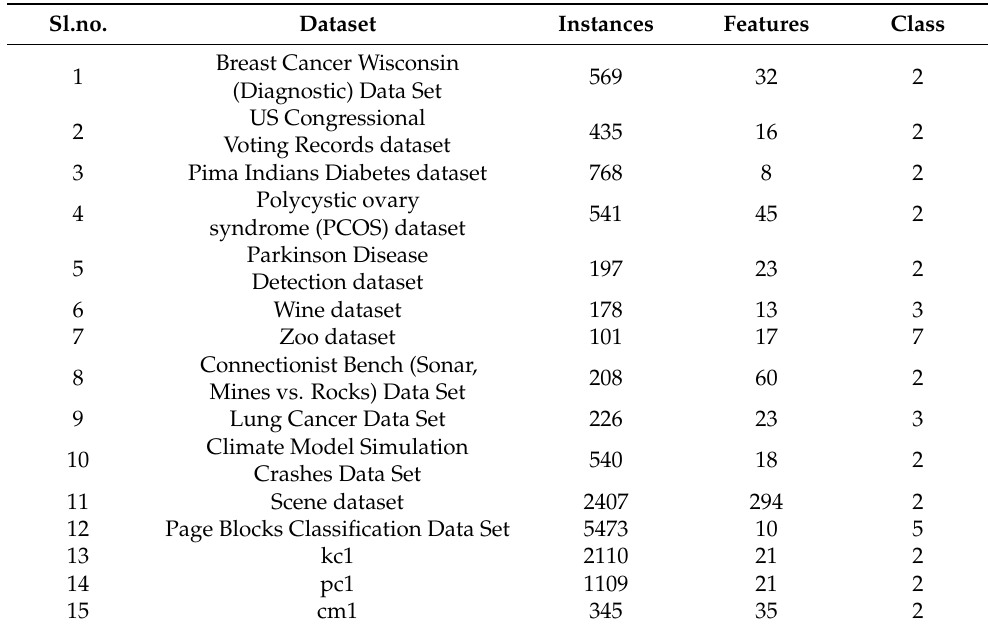
Table 1. Dataset description.